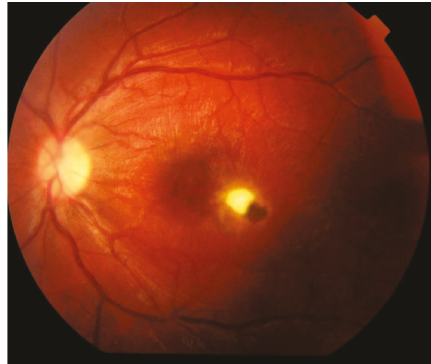
Figure 5: Group I (posttreatment).